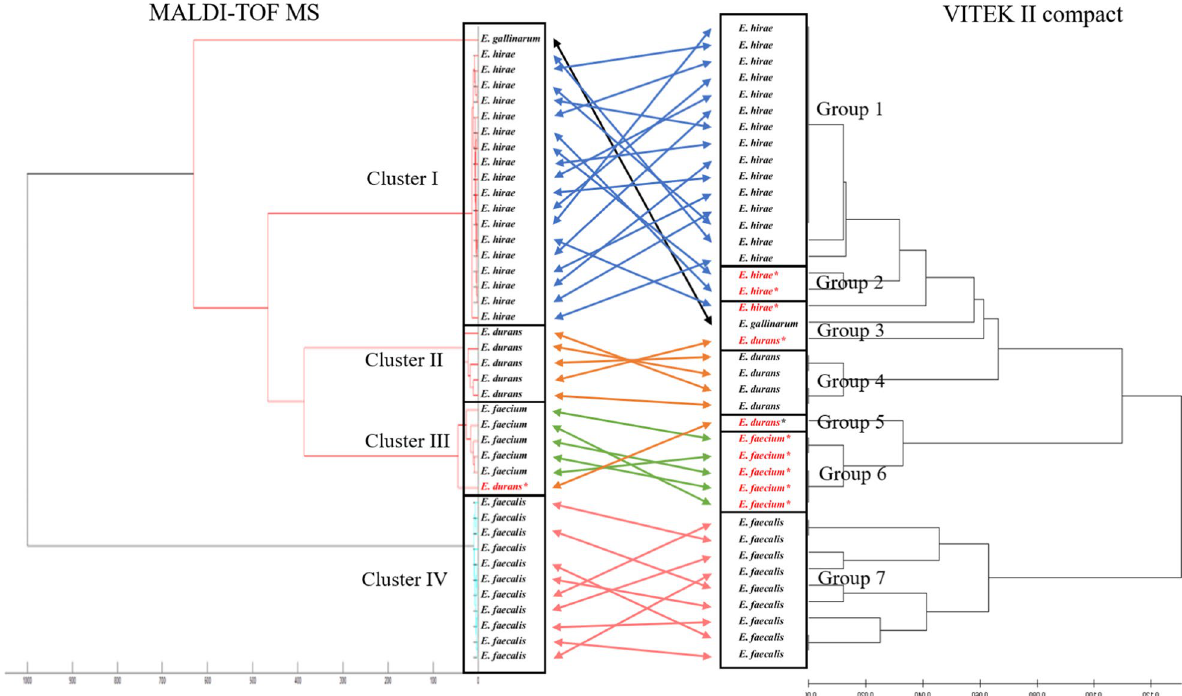
Fig. 1 Comparison of phylogenetic trees obtained from MALDI‑TOF MS spectra (left) and VITEK 2 biochemical patterns (right). Species were interpreted using the results from 16S rRNA sequencing. The arrows indicate the same colony or isolate used for both identification instrument. The species names illustrated are from 16S rRNA sequencing. Therefore, the species names species names with asterisk (*) from 16S rRNA sequencing indicates misidentified isolates by MALDI‑TOF MS or VITEK